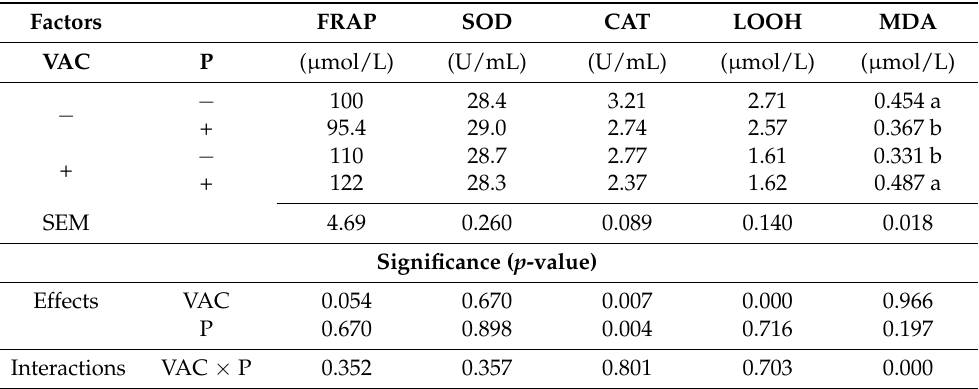
Table 6. Redox status indices of chicken blood collected at 16 d of